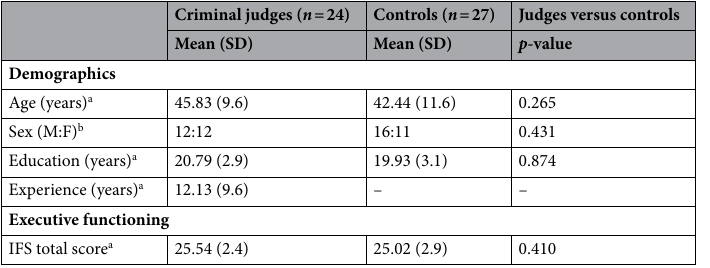
Table 1. Demographic and executive functioning comparisons between groups. a p values were calculated using independent t-test, b p values were calculated using a chi-squared test ( X 2 ). Alpha level set at 0.05. IFS: INECO Frontal Screening battery.